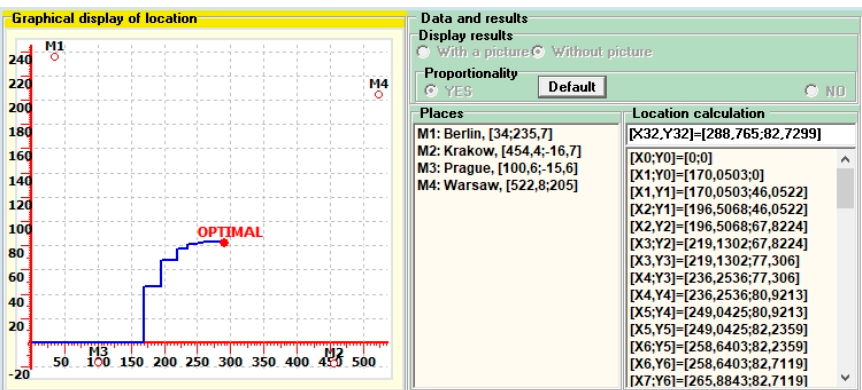
Figure 12. Graphical display of the results and procedure for calculating iterations via the computer-aided location expert system that the author created.